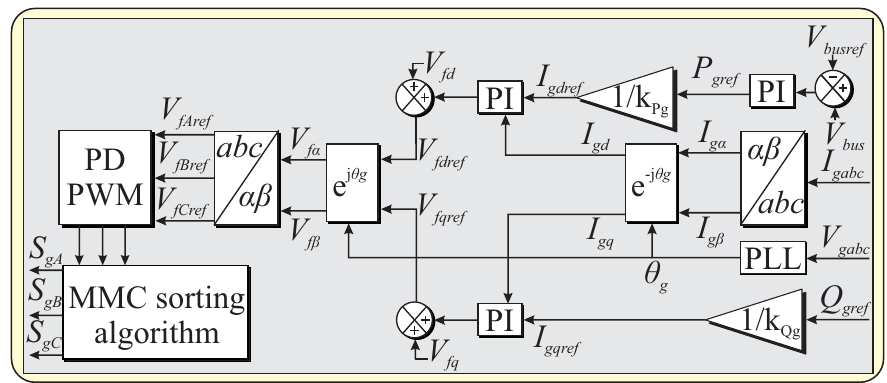
Figure 4. MMC control